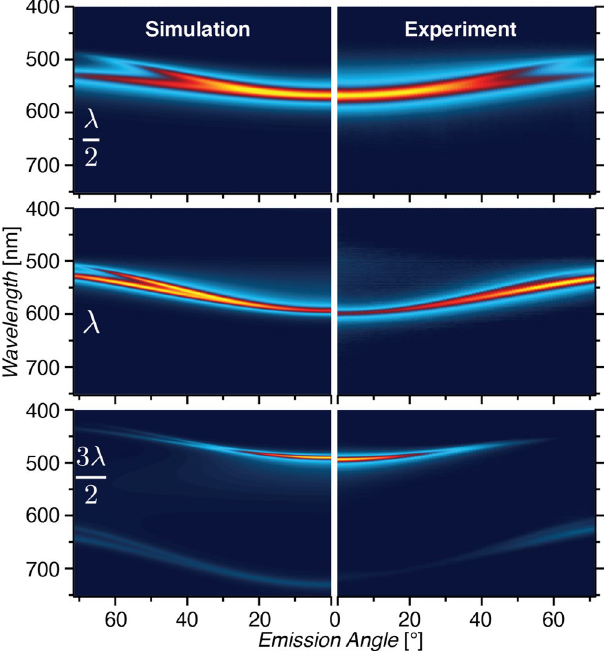
Figure 4. Experimental (right) and simulated (left) ARES data for cavity thickness 113 nm representing the (cid:31) / 2 mode, 282 nm the (cid:31) mode, and 362 nm the 3 (cid:31) / 2